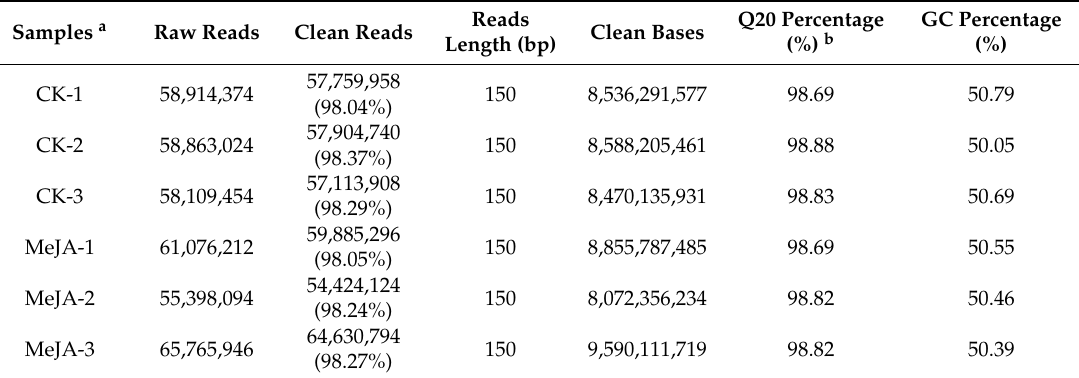
Table 1. Summary of Illumina HiSeq4000 sequencing data.